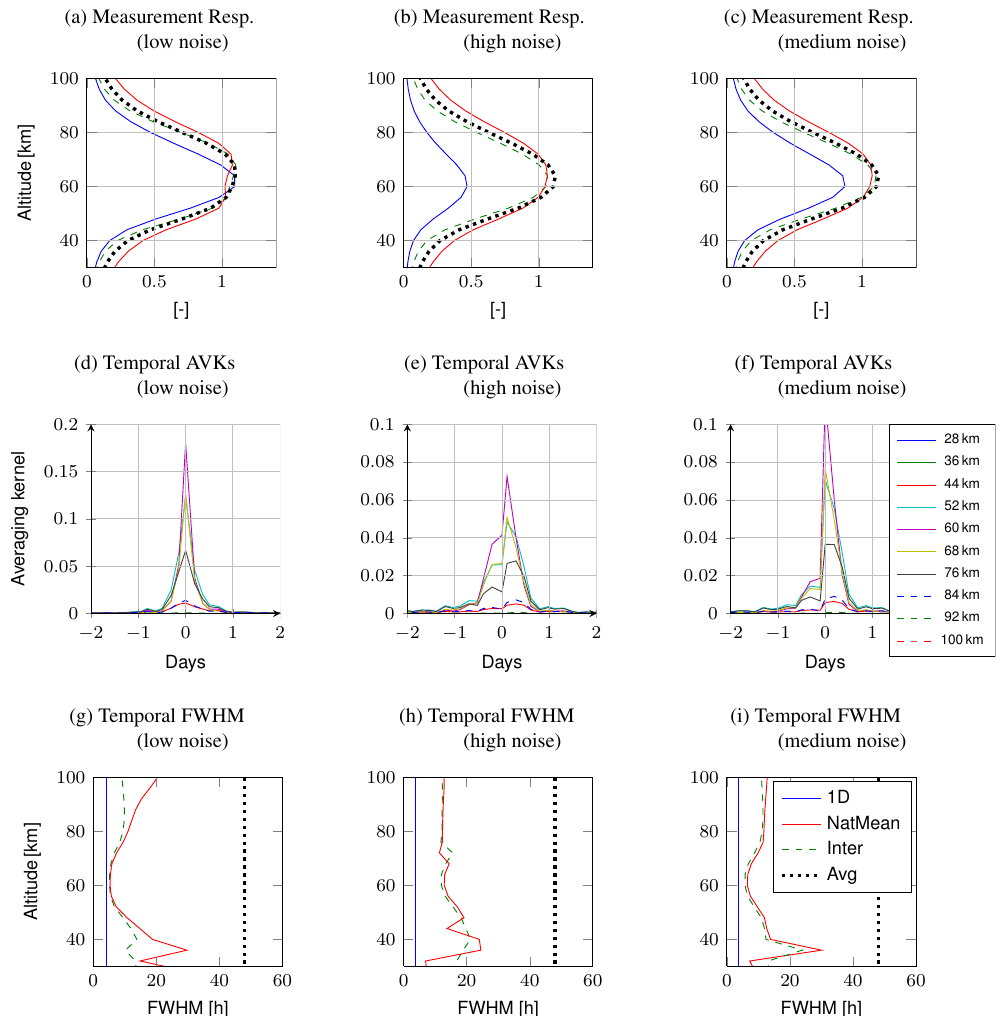
Fig. 8. Properties of the AVKs from three selected measurements from the OSO radiometer. The left column shows the low-noise measurement (10 May 2005), the centre column shows the high-noise measurement (21 May 2005), and the right column shows the intermediate noise measurement (21 May 2005). The first row (a–c) depicts the measurement response of the respective measurements, the second row (d–f) temporal averaging kernels of different altitudes, and the third row (g–i) the FWHM of the temporal AVKs. The different curves in the first and last rows represent the single spectrum inversions (blue), the time series inversions using the NatMean (red) and the intermediate covariance matrix (dashed-green), and the inversions using the averaged spectra (black-dashed).